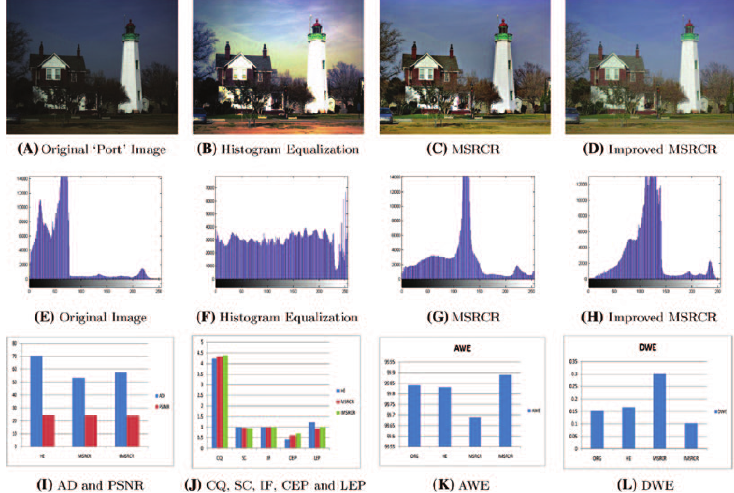
Figure 2. (Top) Image Enhancement Methods. (Middle) Histogram Plots: x -axis, Intensity Levels Ranging from 0 to 255; y -axis, Total Number of Pixels. (Bottom) Conventional Metrics and Proposed AWE and DWE Metrics. The “Port” Image has been Downloaded from